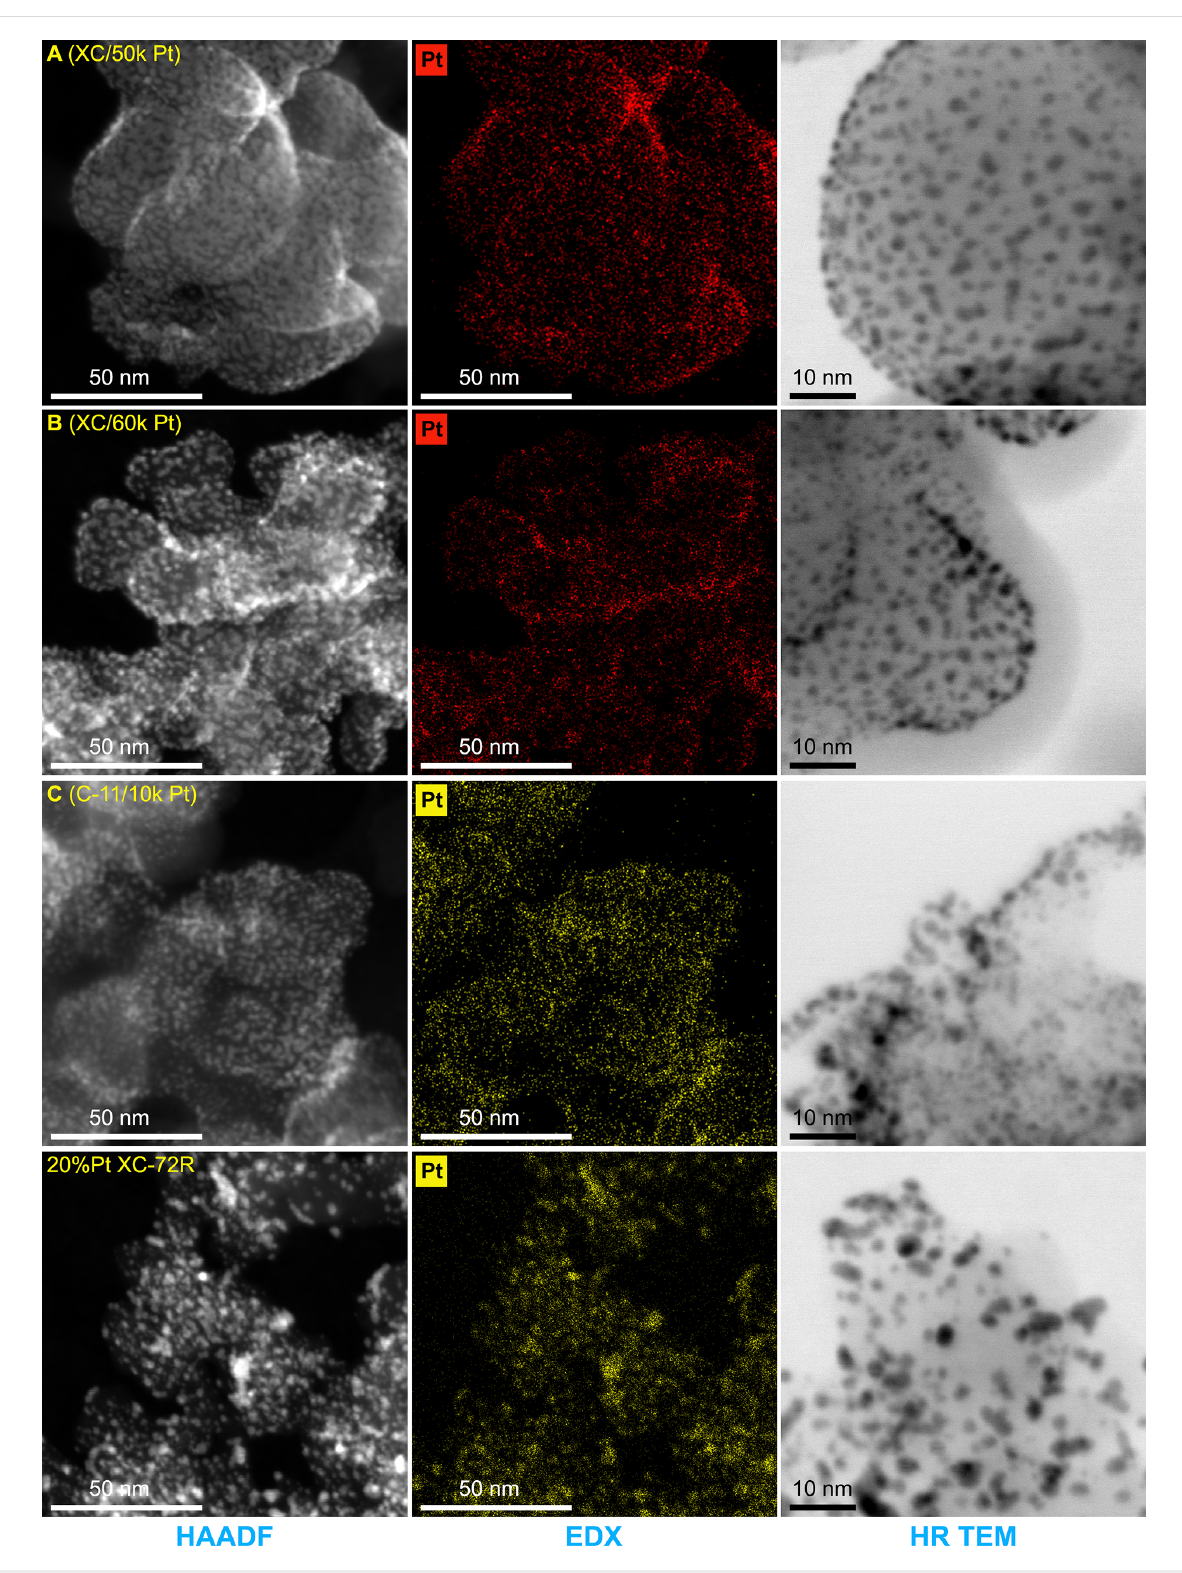
Figure 3: Results of TEM and EDX measurements of selected samples with Pt deposited using PLD and reference catalyst 20% Pt XC-72R. In the three columns, the results of HAADF, EDX, and HRTEM measurements are shown. Statistical analysis of Pt nanoparticle area distribution is shown in Supporting Information File 1, Figure